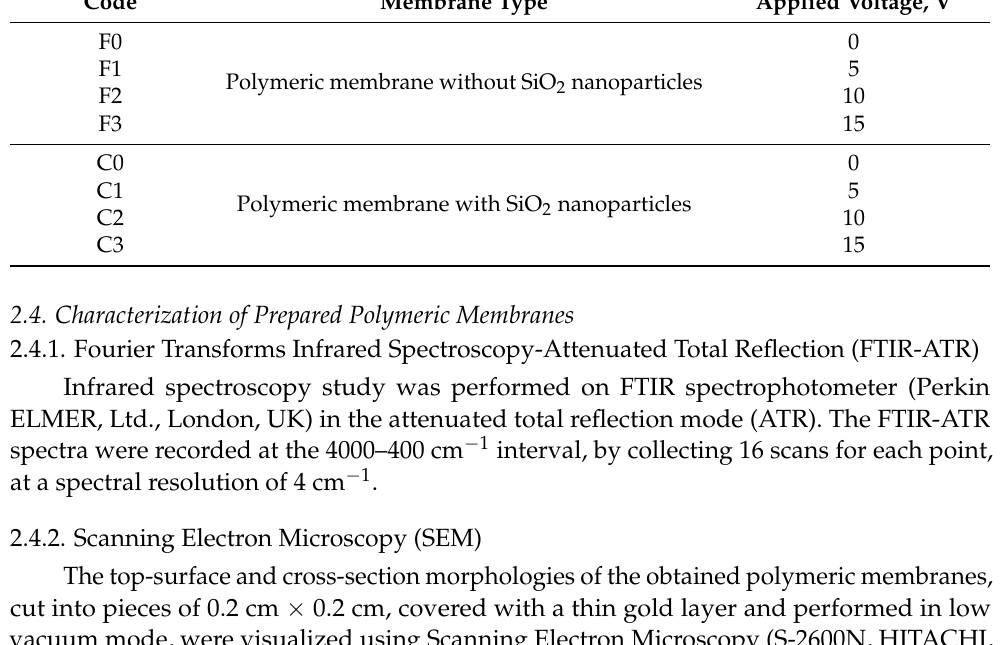
Table 1. Codes of polymeric membranes without and with SiO 2 nanoparticles, before (applied voltage: 0 V) and after electrodialysis process (applied voltage: 5, 10 and 15 V).